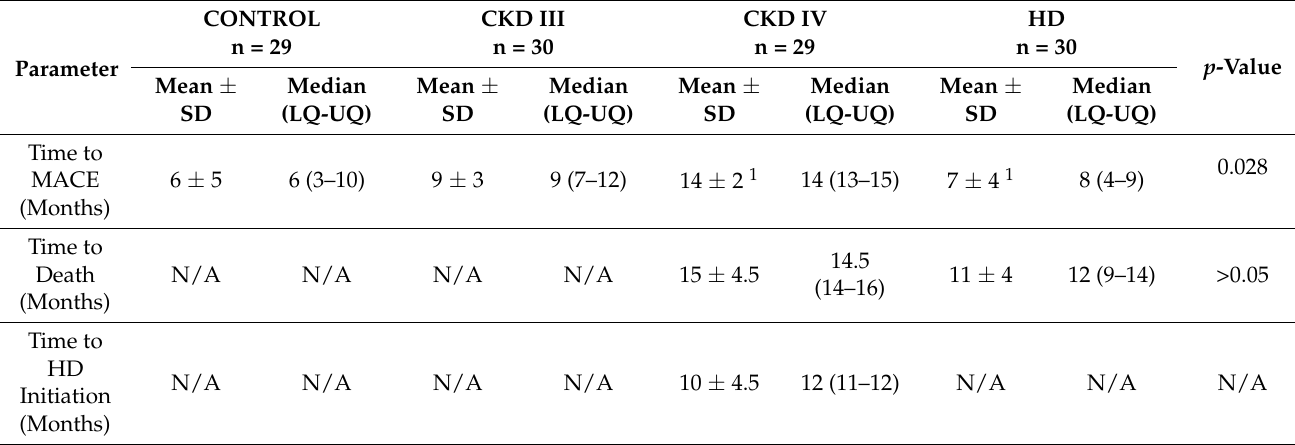
Table 5. Quantitative data on recorded endpoints with statistical evaluation (Kruskal-Wallis ANOVA). Data are shown as mean ± SD and median (lower quartile—upper